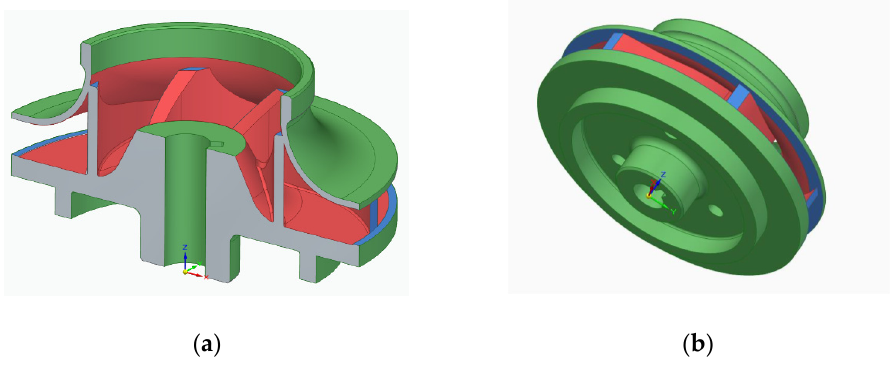
Figure 3. Support material deposition: red: impossible to remove; blue: difficult to machine; green: easy to remove: ( a ) closed impeller—section view and ( b ) closed impeller—isometric view.